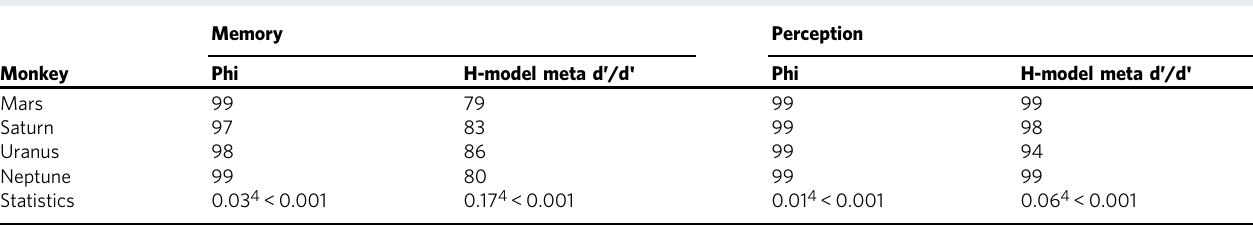
Table 1 Percentiles of each monkey ’ s meta-scores compared with the simulated